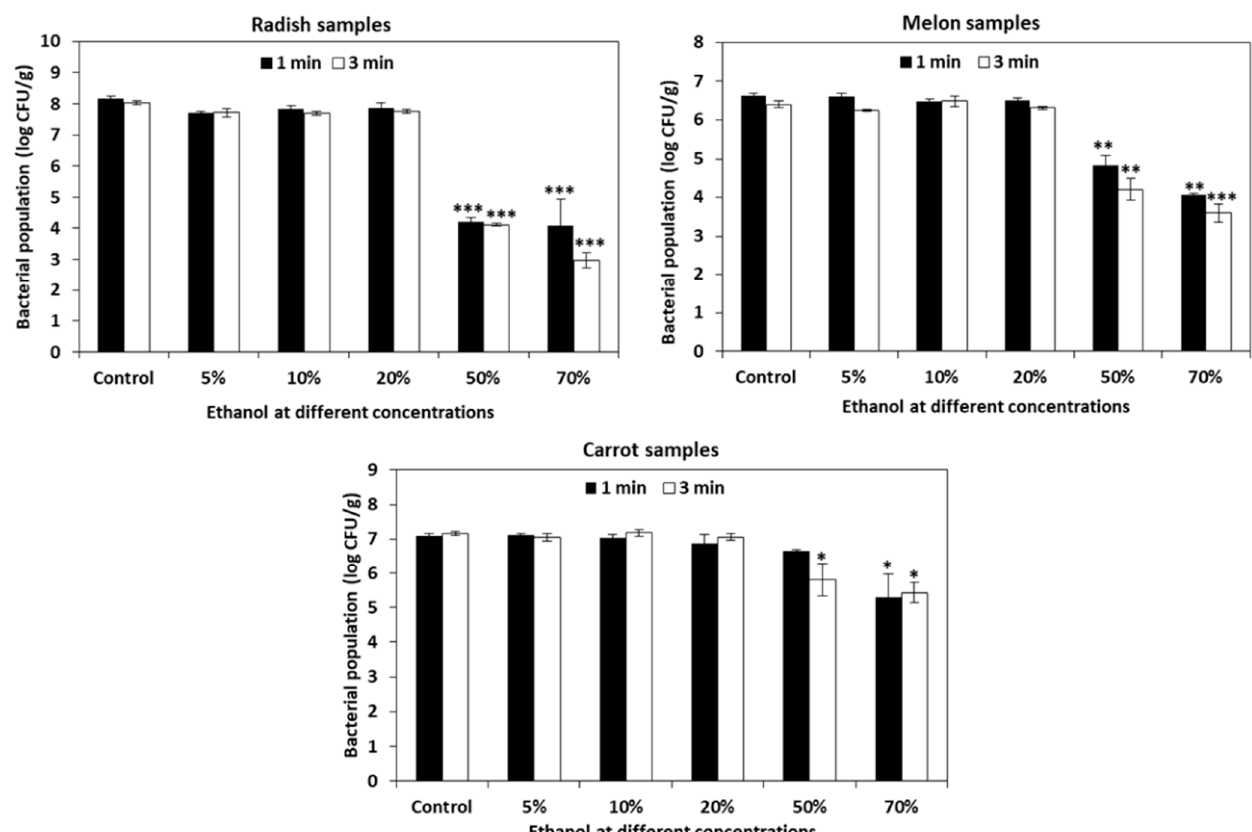
Figure 4. Efficiency of ethanol against Listeria monocytogenes in cut vegetable samples of radish, melon, and carrot. Ethanol at different concentrations (5%, 10%, 20%, 50%, and 70%) was applied on radish, melon, and carrot samples for 1 and 3 min and its effectiveness against L. monocytogenes was analyzed. The data obtained are the means ± SD from three independent experiments with triplicates. Statistical analysis (t-test) was conducted using SigmaPlot. For t -test analysis, the values of ethanol-treated cut vegetable samples were compared with those of the untreated cut vegetable control samples. An asterisk indicates significant differences compared with the control (* p < 0.01, ** p < 0.001, *** p < 0.001).